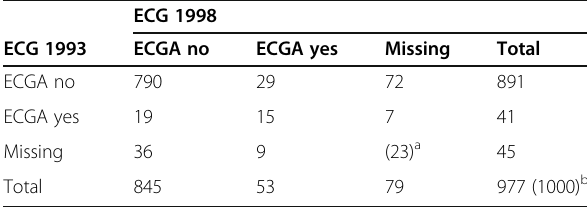
Classification of ECG outcomes The 977 participants were classified into three ECG categories as follows: ECG category 0, ECG performed in 1993 and 1998, no ECGA, ( n = 790); ECG category 1, ECG performed in 1993 and/or 1998, one or more abnormalities ( n = 79); and ECG category 9, ECG performed in 1993 or 1998 without abnormality ( n =